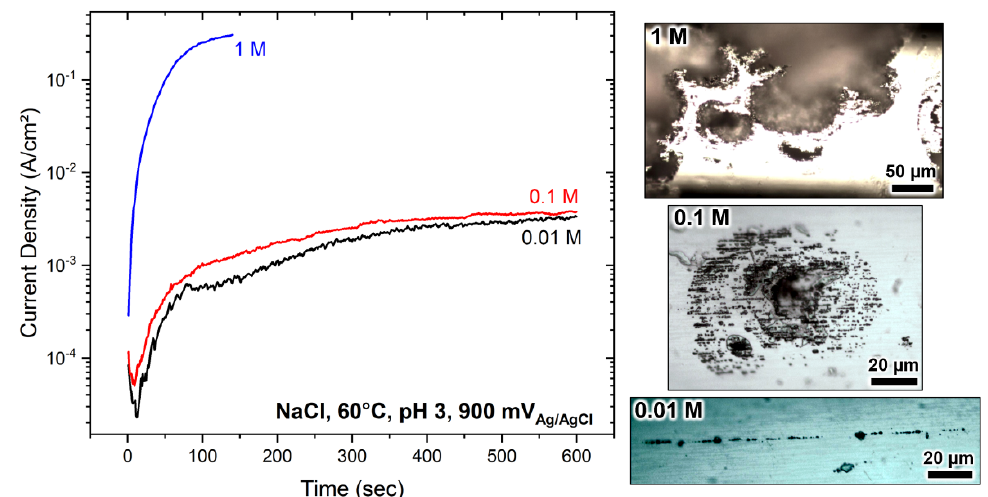
Figure 2. Potentiodynamic polarisation (1 mV/s) in NaCl solutions at pH 3 and 60 °C.